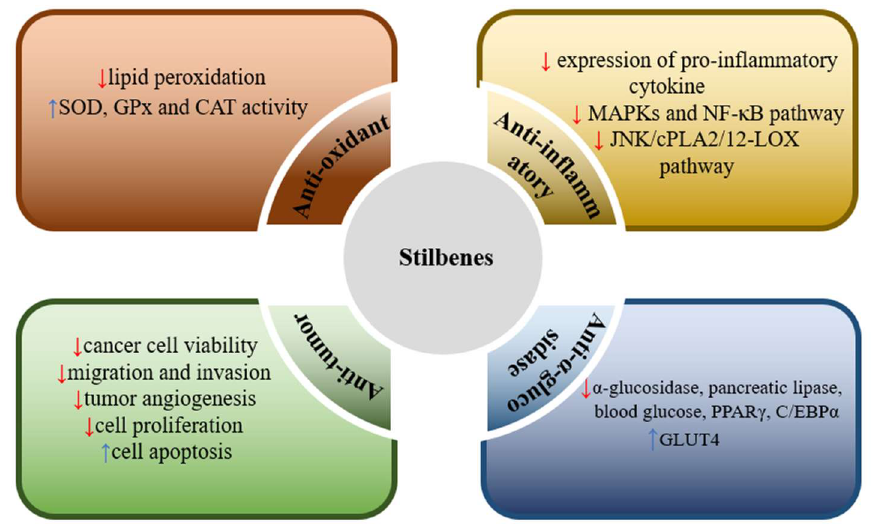
Figure 3. Major biological activities and their mechanisms of action of stilbenes in Dendrobium species. Anti-oxidant (inhibiting lipid peroxidation, increasing SOD, GPx and CAT activity); Anti- inflammatory (through inhibition of expression of pro-inflammatory cytokines, such as TNF- α , IL-6, IL-1 β , blockage of NF- κ B activation and phosphorylation of MAP kinases, inhibiting the JNK/cPLA2/12-LOX pathway); Anti- α -glucosidase (through inhibition α -glucosidase and pancre- atic lipase, suppression of PPAR γ and C/EBP α expression); Anti-cancer (through inhibition cancer cell viability, migration and invasion, tumor angiogenesis, cell proliferation and increasing cell apoptosis) activities.